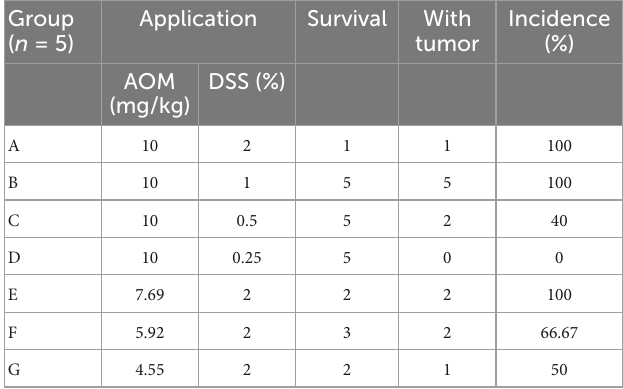
TABLE 1 Incidence of tumor in mice treated with different doses of AOM/DSS. Group Application Survival With ( n = 5)